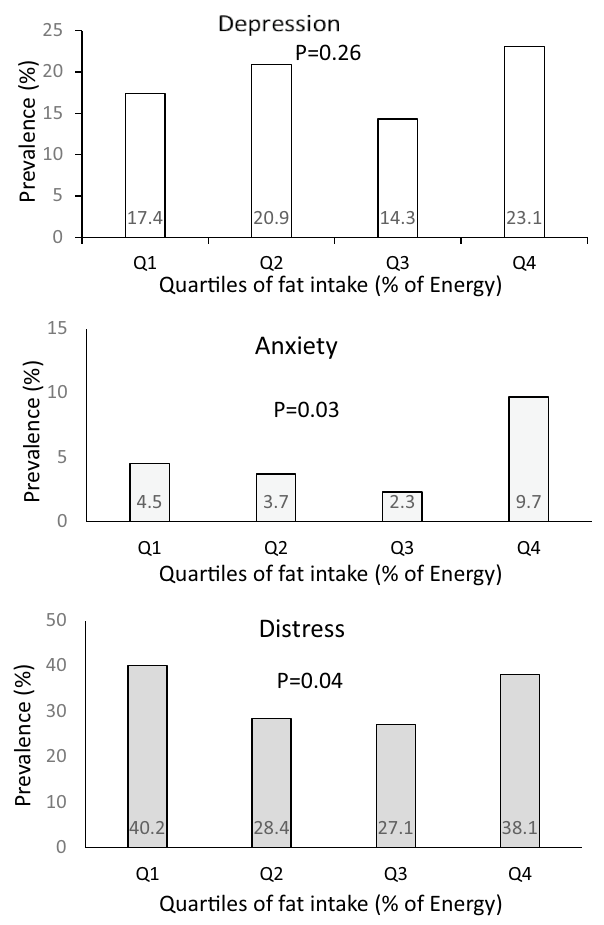
Figure 1. Prevalence of psychological disorders across quartiles of fat intake (as percentage of energy